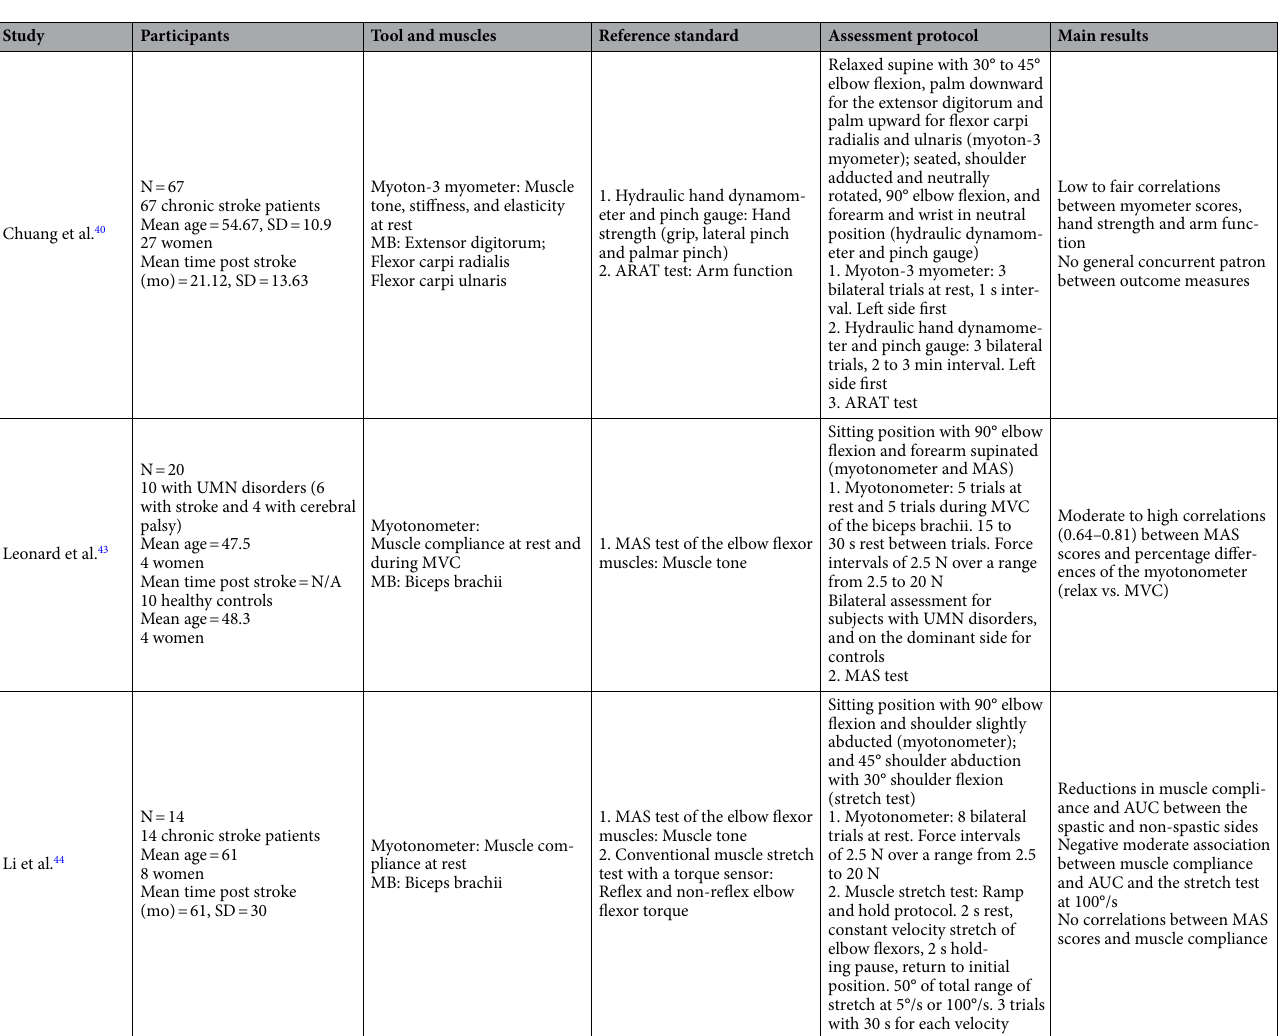
Table 1. Main characteristics of selected studies analyzing validity of the myotonometry in the upper limbs. ARAT: Action Research Arm Test; AUC: area under the curve; N: newton; N/A: non available; MB: muscle belly; mo: months; MVC: maximal voluntary contraction; UMN: upper motor